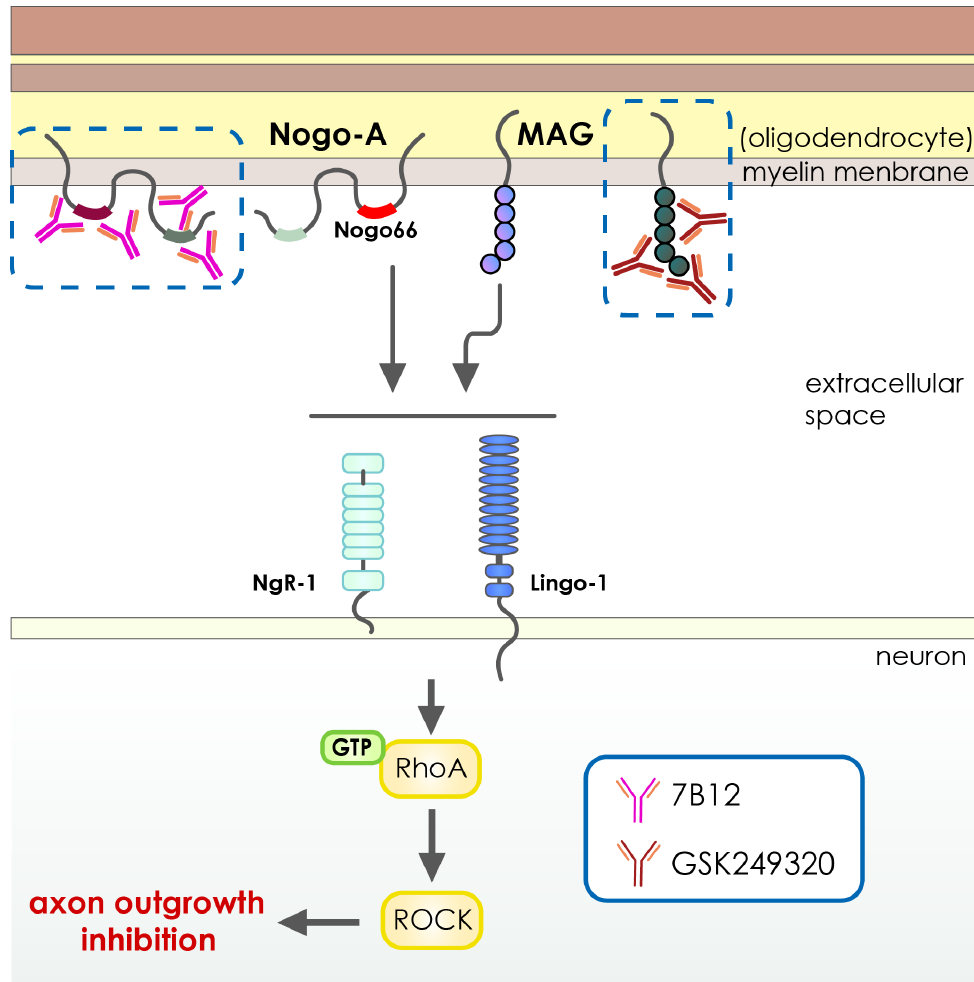
Figure 5. Schematic illustration of MAG or Nogo-A signaling cascades in the pathology of cerebral ischemia. The overproduction of Myelin-associated glycoprotein (MAG) Neurite outgrowth inhibition protein-A (Nogo-A) after cerebral ischemia activates the signaling cascades linked to the RhoA/ROCK pathway, which collapses neuronal growth cones and inhibits axonal growth. Such inhibitory events significantly suppress the functional recovery after the suffering of cerebral ischemia. Inhibition of the MAG or Nogo-A with highly specific antibody-based therapeutics can enhance the axonal regeneration and neurite outgrowth dramatically, which leads to better functional recovery after cerebral ischemia. Meanwhile, a recent preclinical, randomized, controlled, multicenter trial testing cerebral ischemia therapy in a mouse model focused on anti-CD47d antibodies that inhibit leukocyte migration into the brain [137]. The study found that treatment with CD49d- specific antibodies significantly reduced both leukocyte invasion and infarct volume after permanent distal middle cerebral artery occlusion caused a small cortical infarct [137]. In contrast, anti-CD49d treatment did not reduce lesion size or affect leukocyte invasion after transient proximal middle cerebral artery occlusion that resulted in large lesions [137]. These results suggest that the utility of immunologic approaches may depend on the severity and location of the